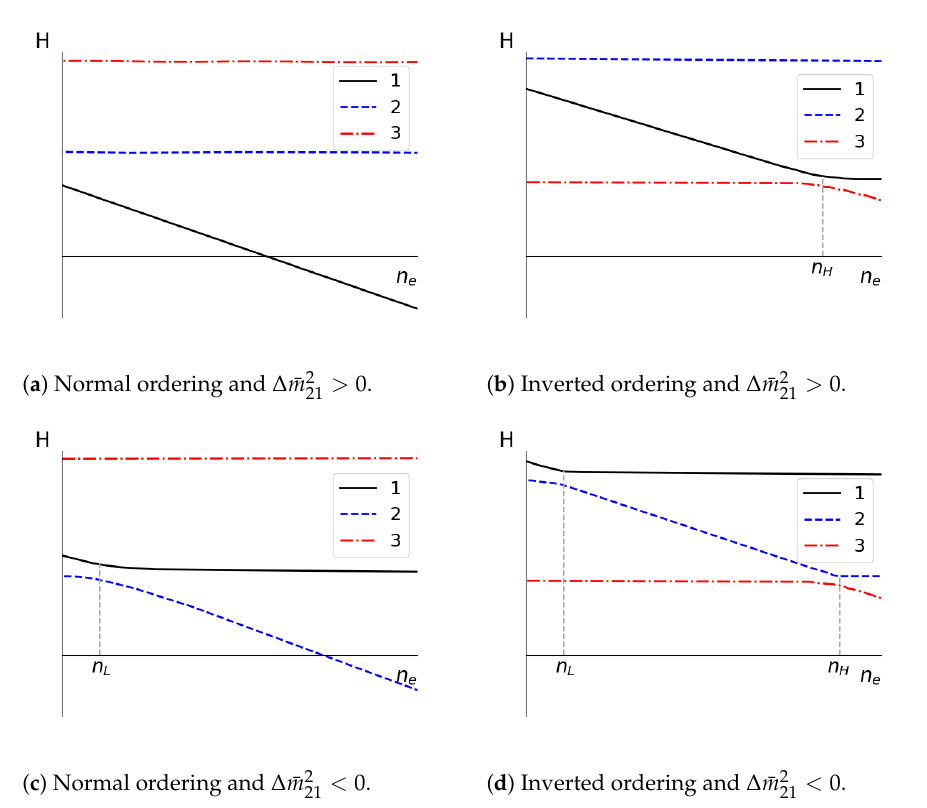
< 0. ( c ) Normal ordering and ∆ ¯ m 2 21 Figure 1. Level crossing diagrams for mass eigenstates transitions in SN environment for antineu- trinos. The vertical axes, H , represent the eigenvalue of the eigenstates (1,2,3) from the evolution Hamiltonian as a function of the electronic density, n e , of the medium. n H and n L are the high and low resonance densities, respectively. Figure adapted from Ref.